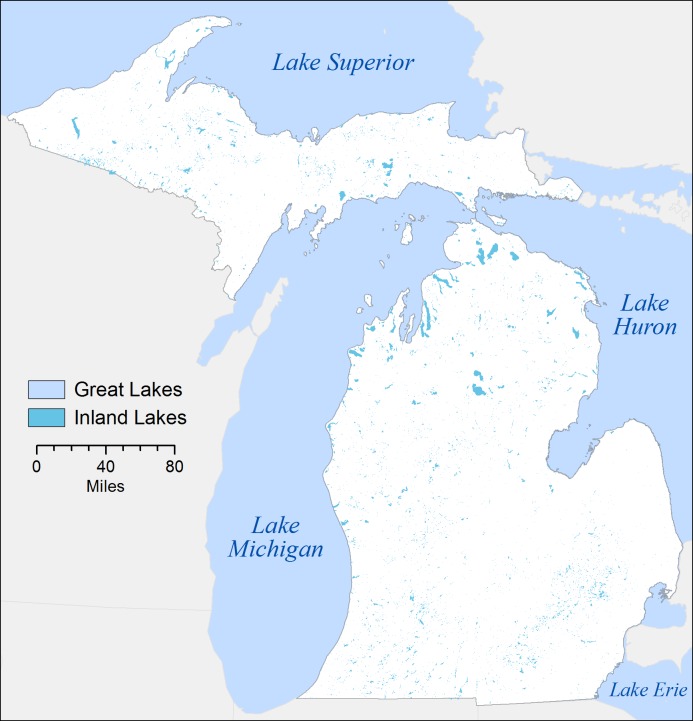
Map of Michigan’s inland lakes, surrounded by North American Great Lakes (created by authors).